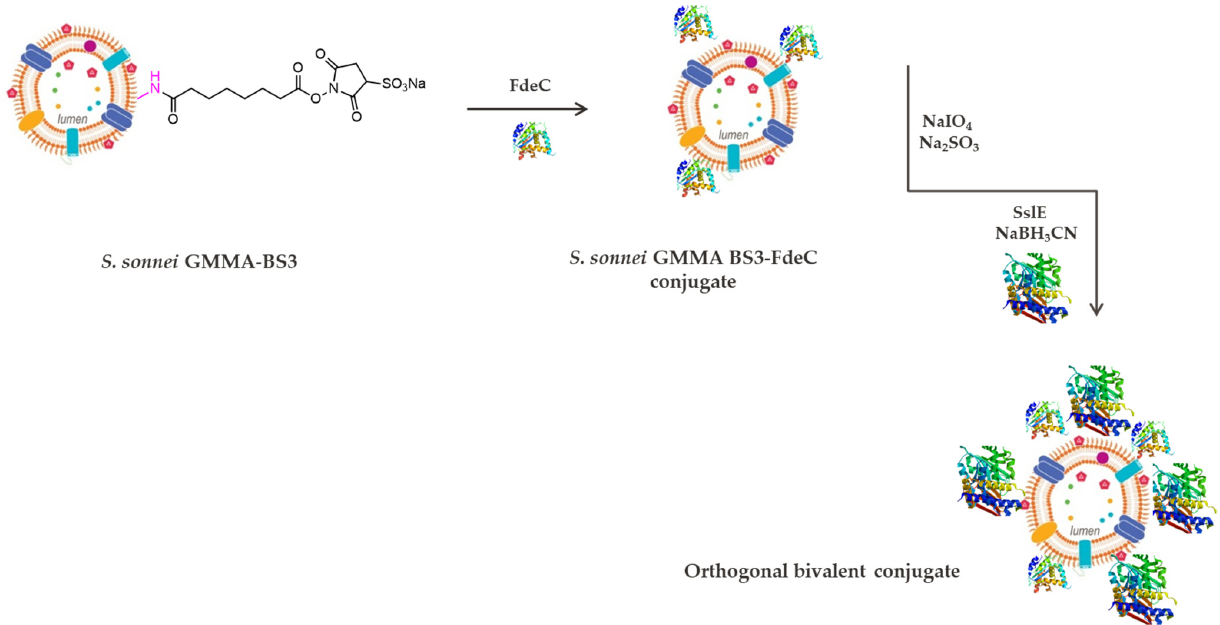
Figure 9. Conjugation strategy used for generation of a bivalent conjugate: conjugation of FdeC on S. sonnei GMMA through BS3 chemistry, followed by oxidation and linkage to SslE by reductive amination.